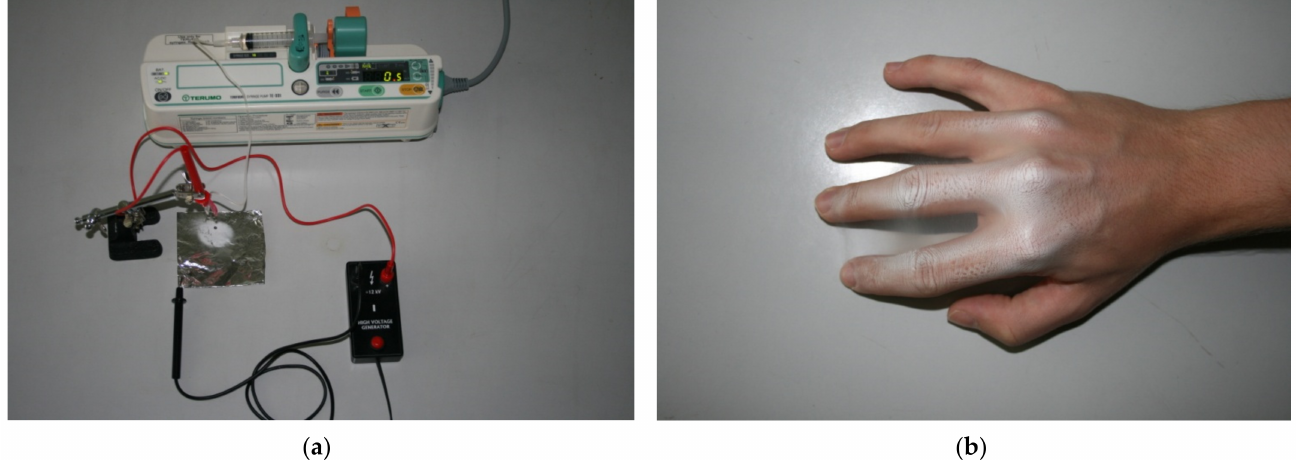
Figure 3. Electrospinning of polycaprolactone nanofibers: ( a ) experimental setup; ( b ) nanofibers can be deposited directly to the skin.